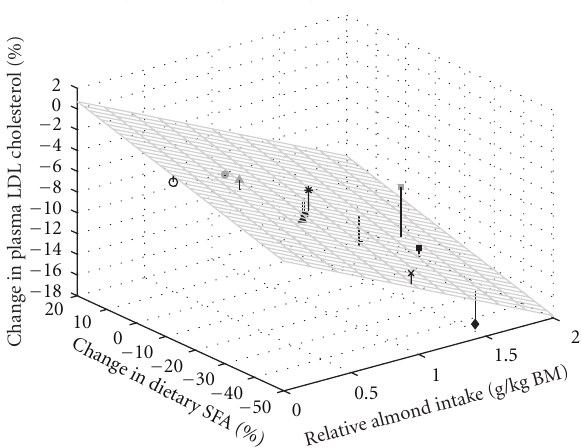
Figure 3: Multiple regression analysis of independent variables (mean relative almond intake and percent change in mean dietary saturated fatty acid) and percent change in mean plasma low- density lipoprotein cholesterol. Correlation was considered signif- icant at P < 0 . 05. See Figure 1 legend for symbol